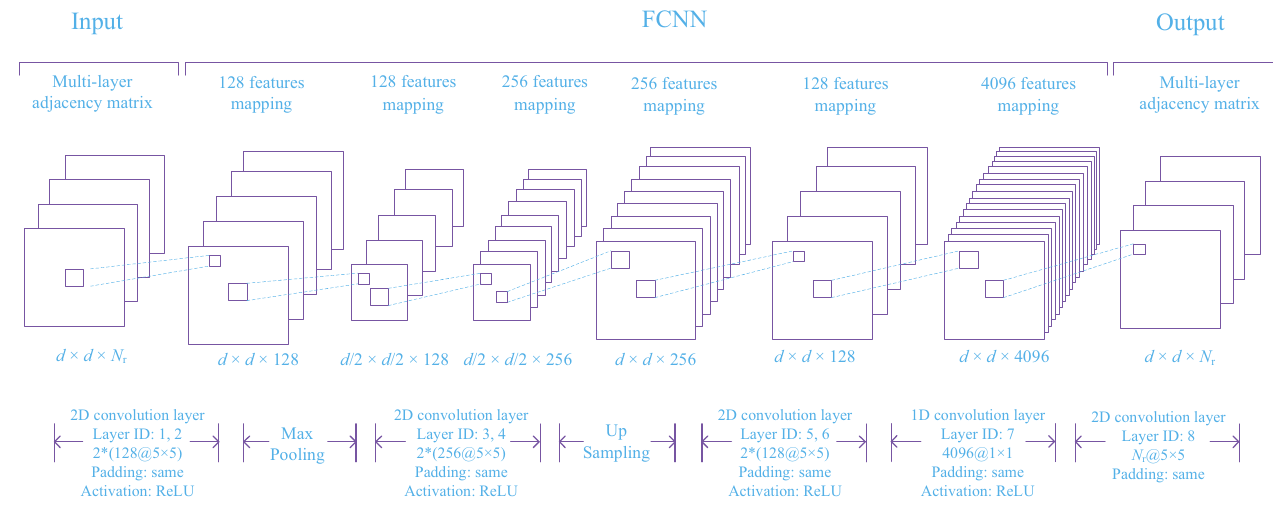
Figure 2. Structure of the